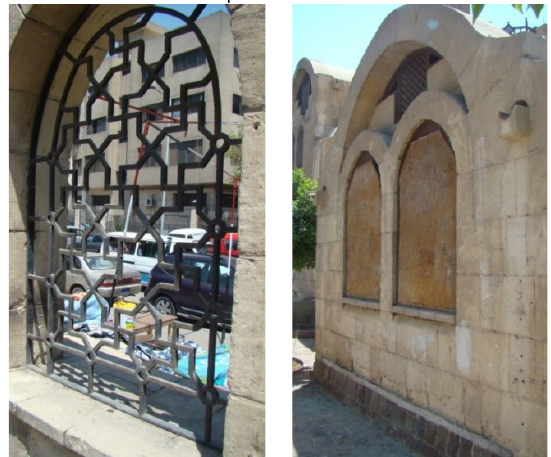
Figure 17. Mulid Temporary Structures in Abu-Eldahab Street, Authors,